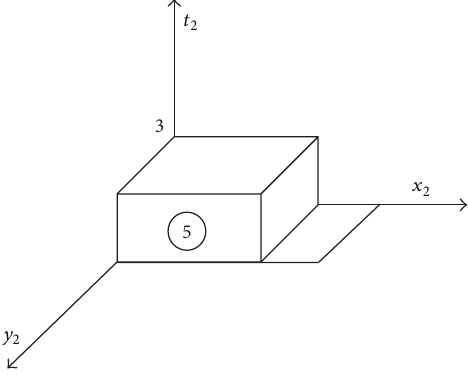
Figure 4: The status of place 2 while activity 5 is put.